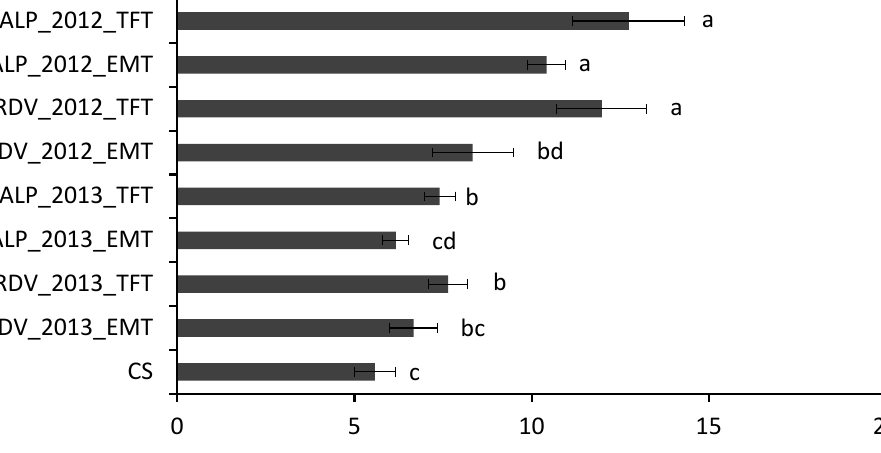
Fig. 1. Sugar to acid ratio determined in Alpine (ALP) and Regina delle Valli (RDV) F. vesca strawberries harvested in two consecutive years (2012 and 2013) and grown under two different fertilisation treatments (EMT = Effective Microorganism Technology; TFT = Traditional Fertilisation Treatment), in comparison with a commercial sample (CS, unknown cultivar). All data referred to dry weight. Values with at least one common letter are not statistically